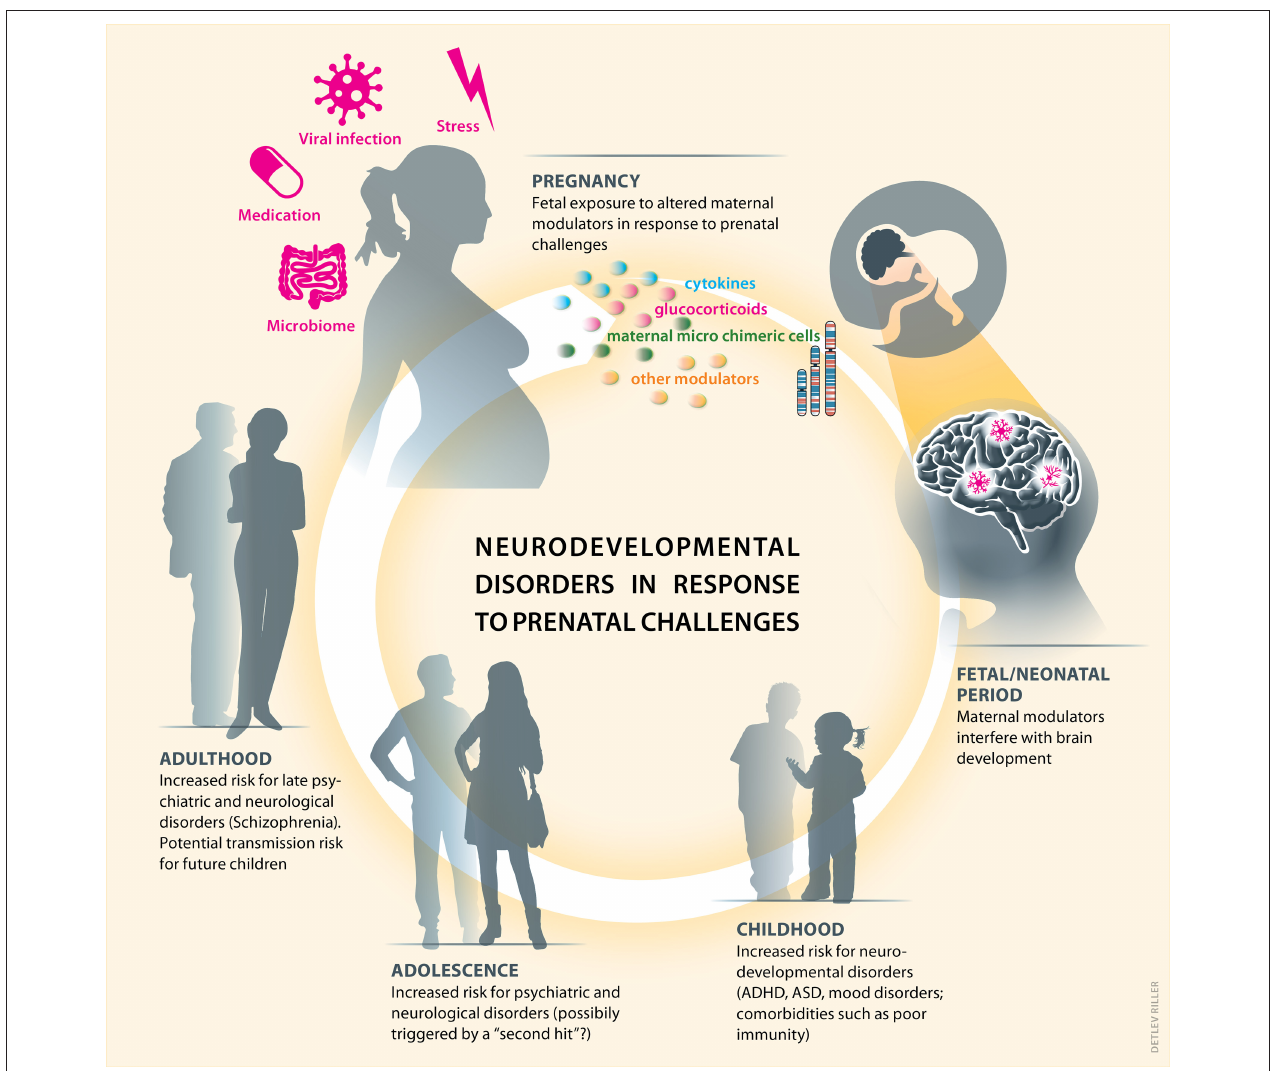
FIGURE 3 | Prenatal challenges and related alterations of immune and endocrine markers can prime postnatal neurodevelopmental disorders. Maternal well-being and health can be challenged during pregnancy, e.g., by distress or infection. This subsequently leads to increased cytokines and glucocorticoids levels and potentially to altered frequencies or phenotypes of maternal microchimeric cells in the offspring. Upon entering the fetal brain, such vertically transferred maternal modulators can significantly interfere with physiologically occurring brain development. A combination of genetic susceptibility and disturbed brain development can subsequently increase the risk for neurodevelopmental disorders in childhood. Subsequent postnatal environmental challenges —drug abuse, trauma, infection, others—may perpetuate such prenatally triggered risk for neurodevelopmental disorders, psychiatric and neurological diseases during adolescence and adulthood, which can also be passed on to the next